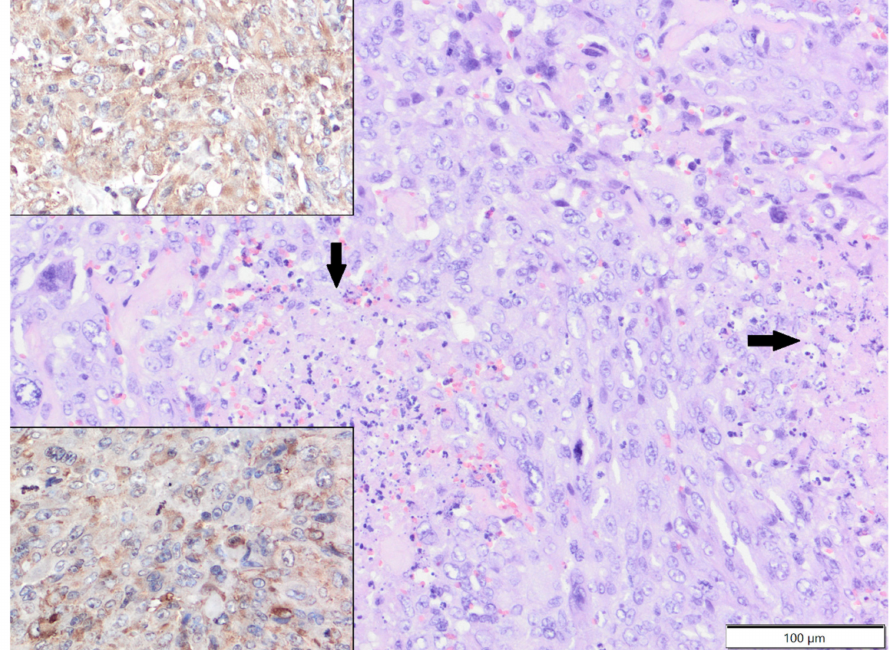
Figure 3. Poorly differentiated sarcoma, tail, ferret. Tumour cells show high anisocytosis and anisokaryosis and undergo necrosis (arrows). HE. Upper inset: tumour cells show cytoplasmic expres- sion of vimentin. IHC. Lower inset: tumour cells show slight cytoplasmic expression of α -SMA. IHC.